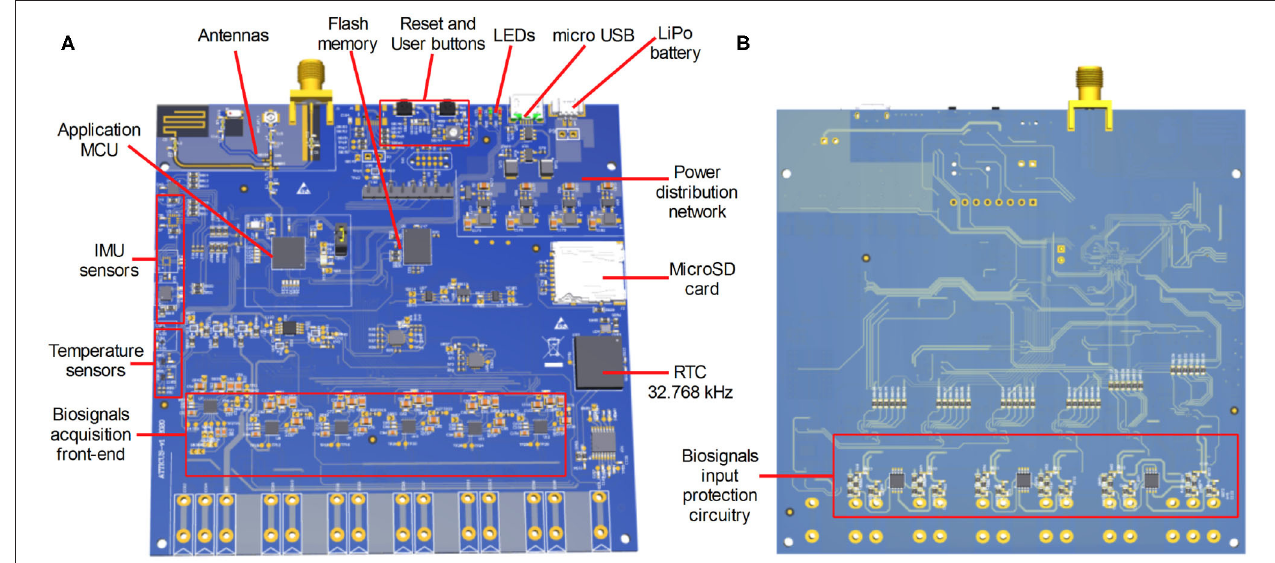
FIGURE 5 | The first PCB evaluation board developed for ATTICUS data acquisition module: (A) the top side of the PCB, and (B) the bottom side of the